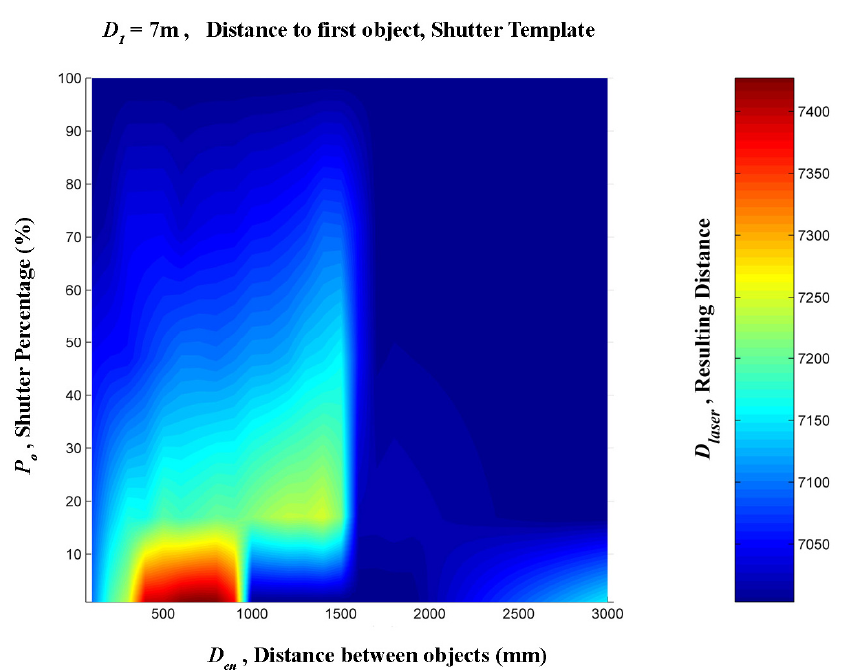
Figure 20. Graphic representation of the distance values (D the results of the progressive blockage of the beam at 90° with the shutter template at a ) of 7,000 mm from the sensor, with different values of D distance (D 1 and 3,000